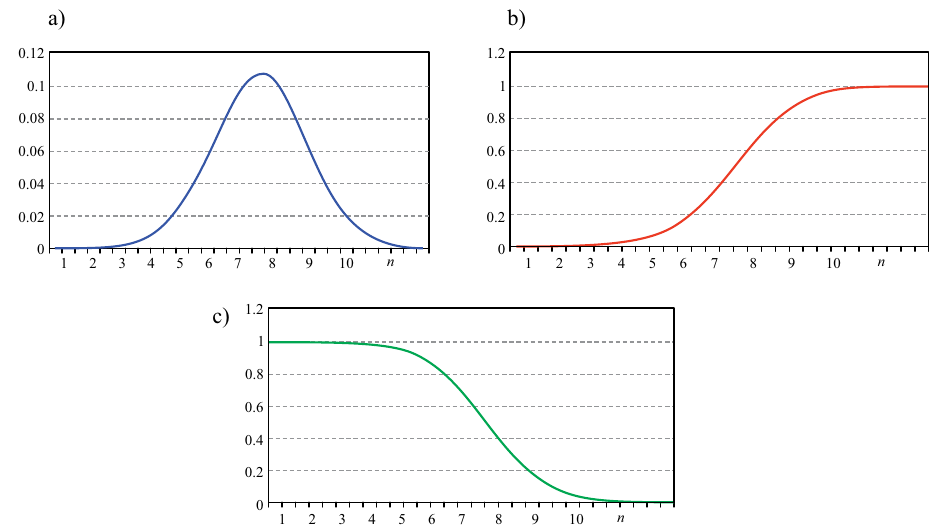
Fig. 3. Distribution of the probability of possibilities regarding the integral multiplier effect: density function (a), distribution function (b), and survival function (c) Note: In specific cases, specific possibility coordinates are formed in the efficiency and reliability